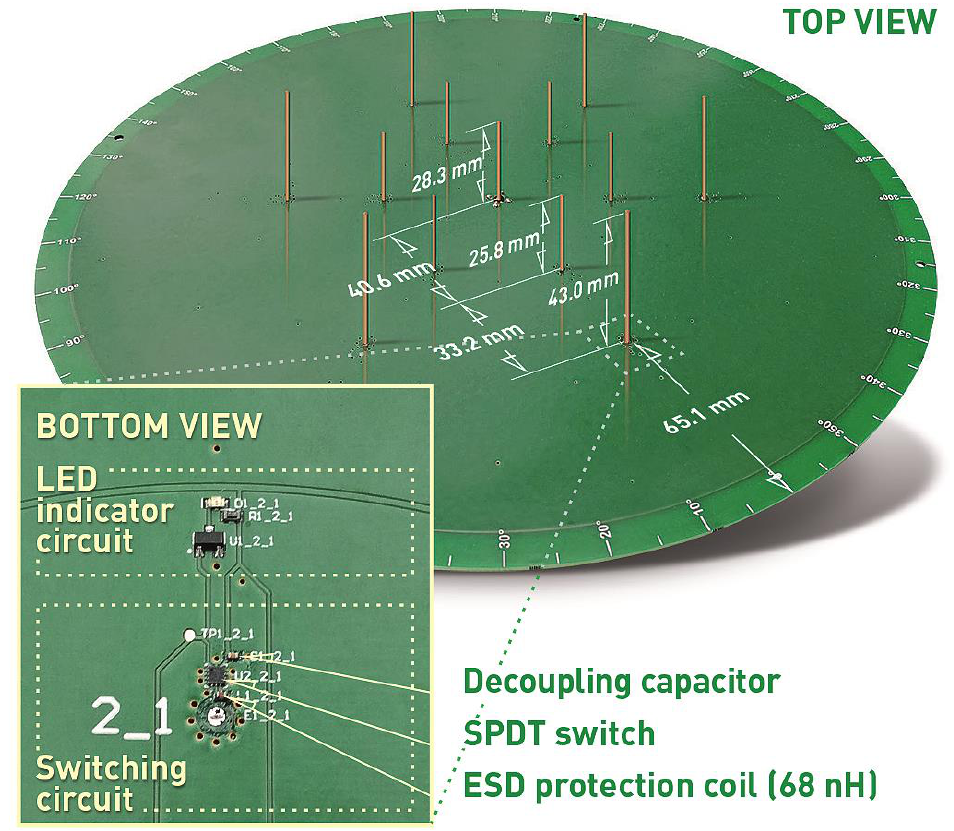
Figure 2. Fabricated two-row ESPAR antenna.